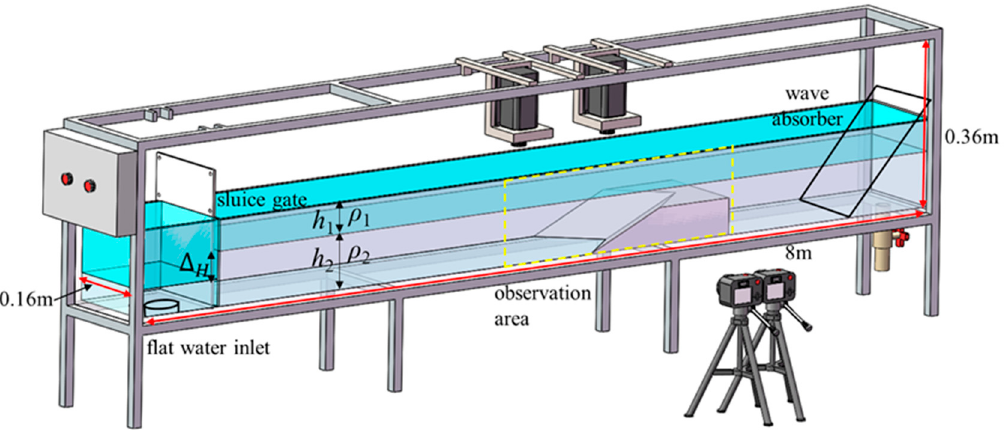
Figure 1. Schematic diagram of the ISW experimental setup.